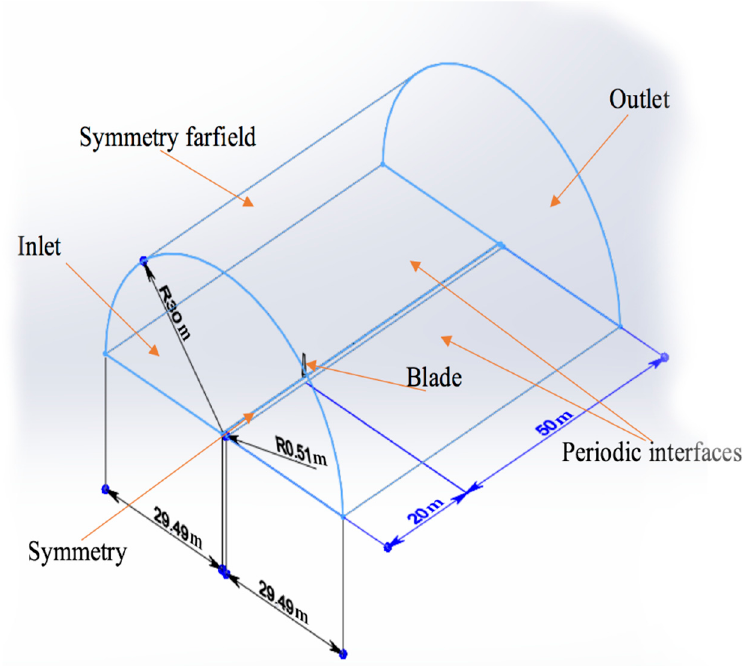
Figure 8. National Renewable Energy Laboratory (NREL) Phase VI wind turbine and fluid domain and boundary conditions (all dimensions in meters).